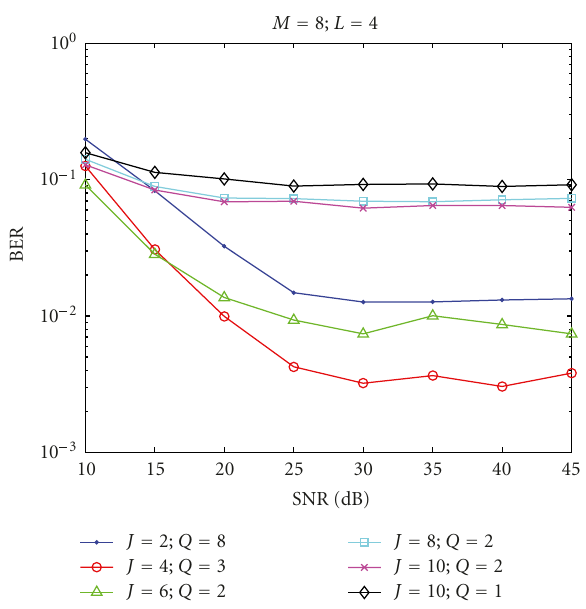
Figure 9: Bit error rate performance for a time-varying